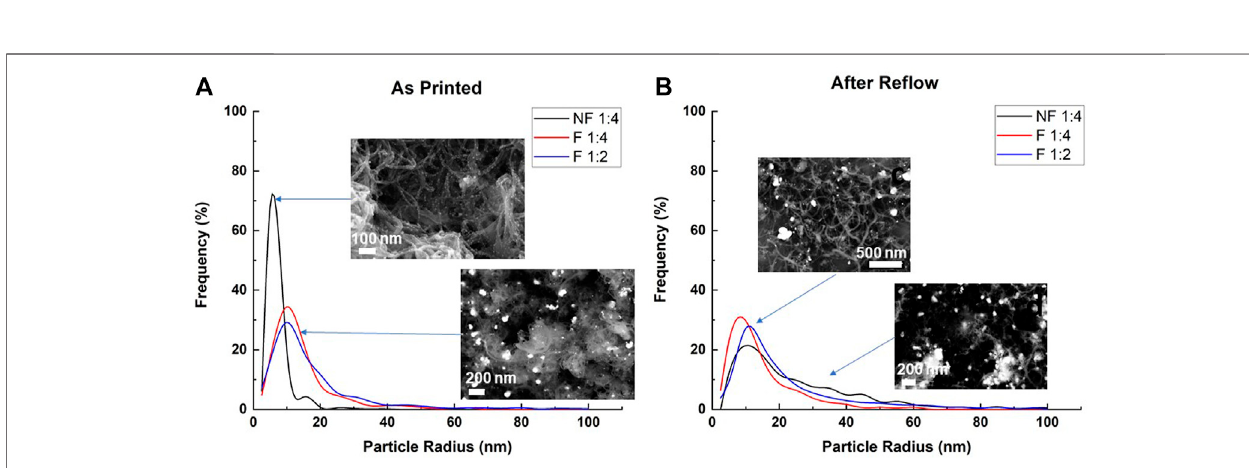
FIGURE 4 | Particle size distribution of: (A) as-printed silver decorated functionalized and pristine CNT samples; and (B) the samples after re fl ow heat treatment. Insets show representative SEM images of the corresponding specimens (the full resolution versions of the images presented here can be found in the SI).